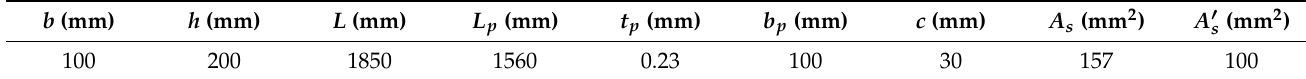
Table 3. Geometric features of RC beam strengthened by CFRP.